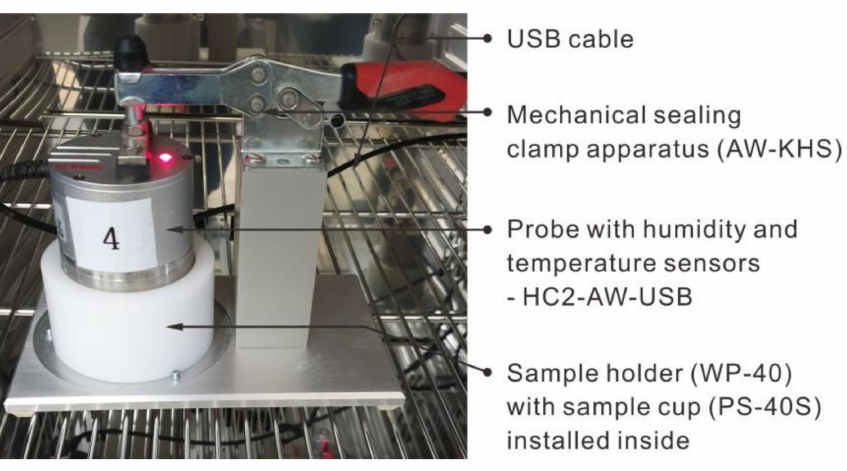
Figure 6. Test setup for measurement of